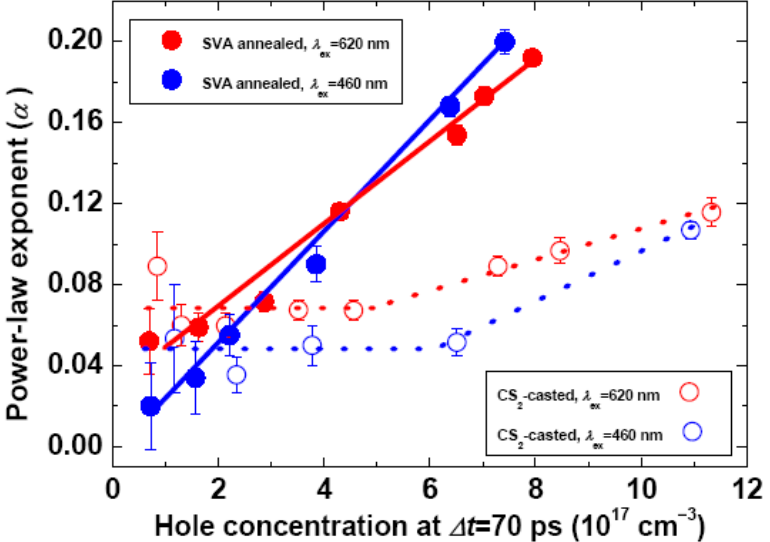
Figure 3. Plot of power-law exponent against the hole concentration (the  -plot) at  t = 70 ps -cast P3HT/PC BM blend films (1:1, w/w) under the excitation wavelengths for SVA and CS 2 61 of 620 nm or 460 nm. The hole concentration were calculated from the  OD amplitudes at  t = 70 ps, for which the extinction coefficient of hole at 1,000 nm and that of exciton at 1,200 nm were assumed to be the same [38]. Solid and dashed lines are for guiding the